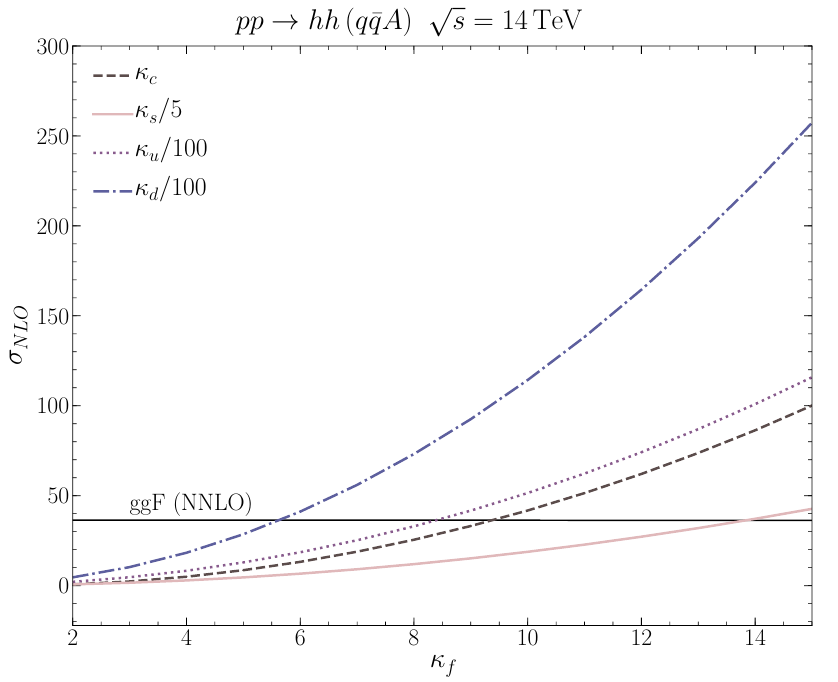
Figure 7 . The NLO cross section for the qqA process for di(cid:11)erent scalings of the quark Yukawa couplings. The solid black line shows the NNLO ggF process width rescaled charm Yukawa coupling, whose e(cid:11)ect though is unrecognisable in the